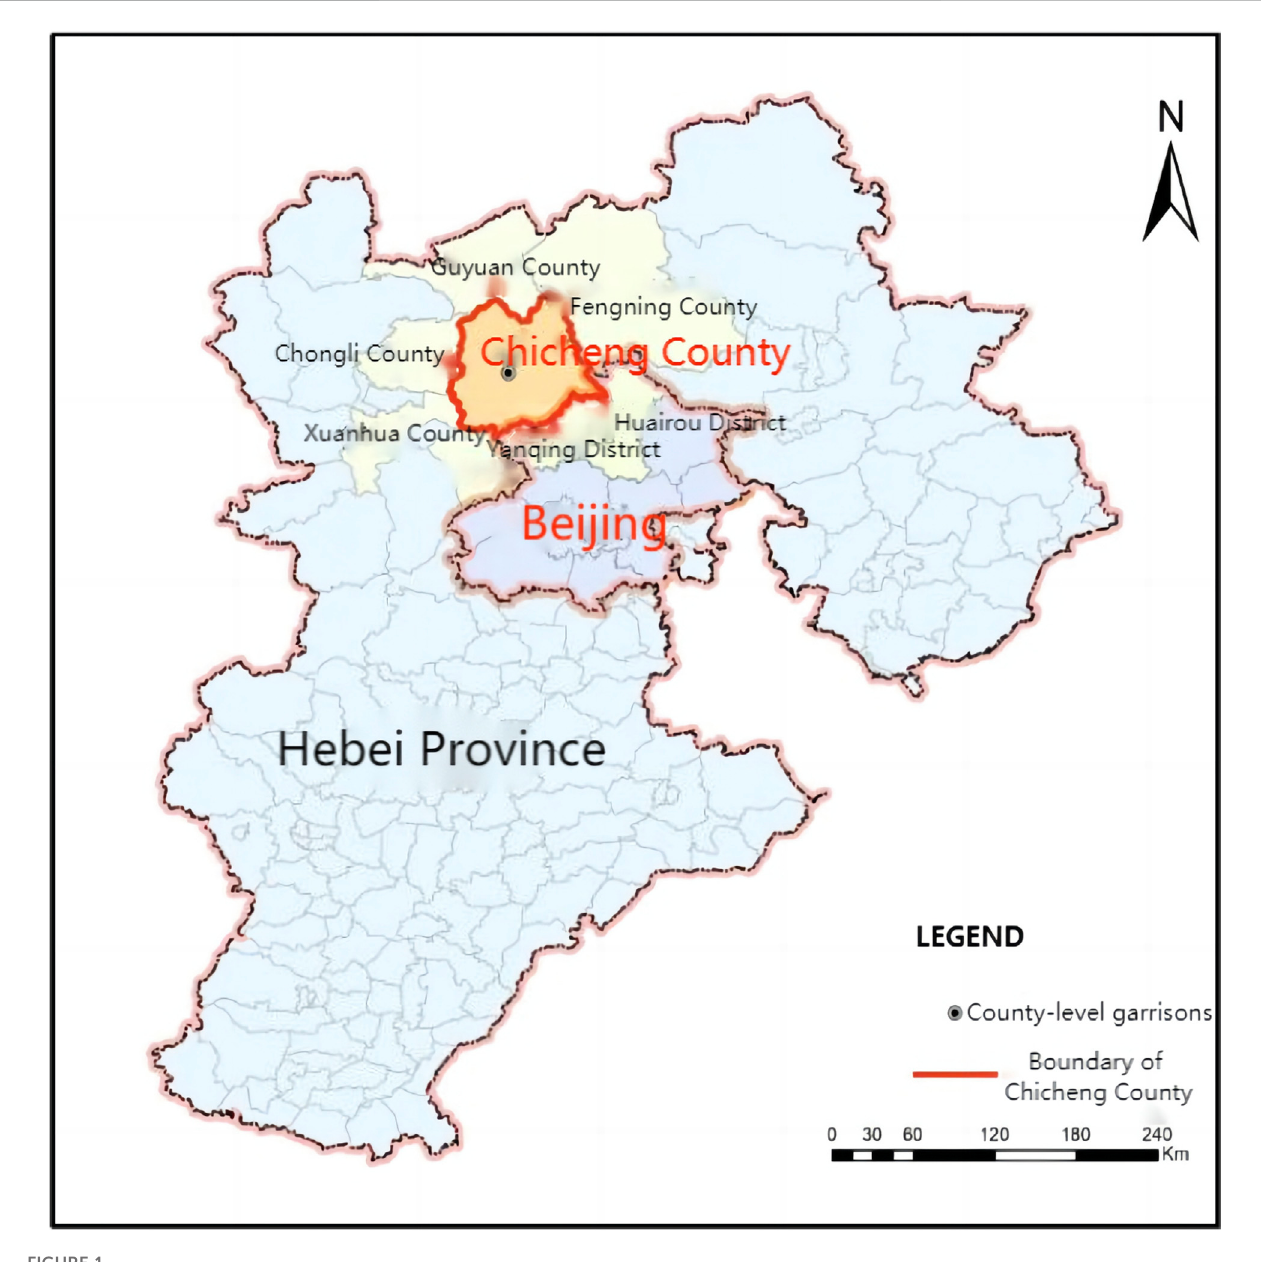
FIGURE 1 Geographical map of Chicheng